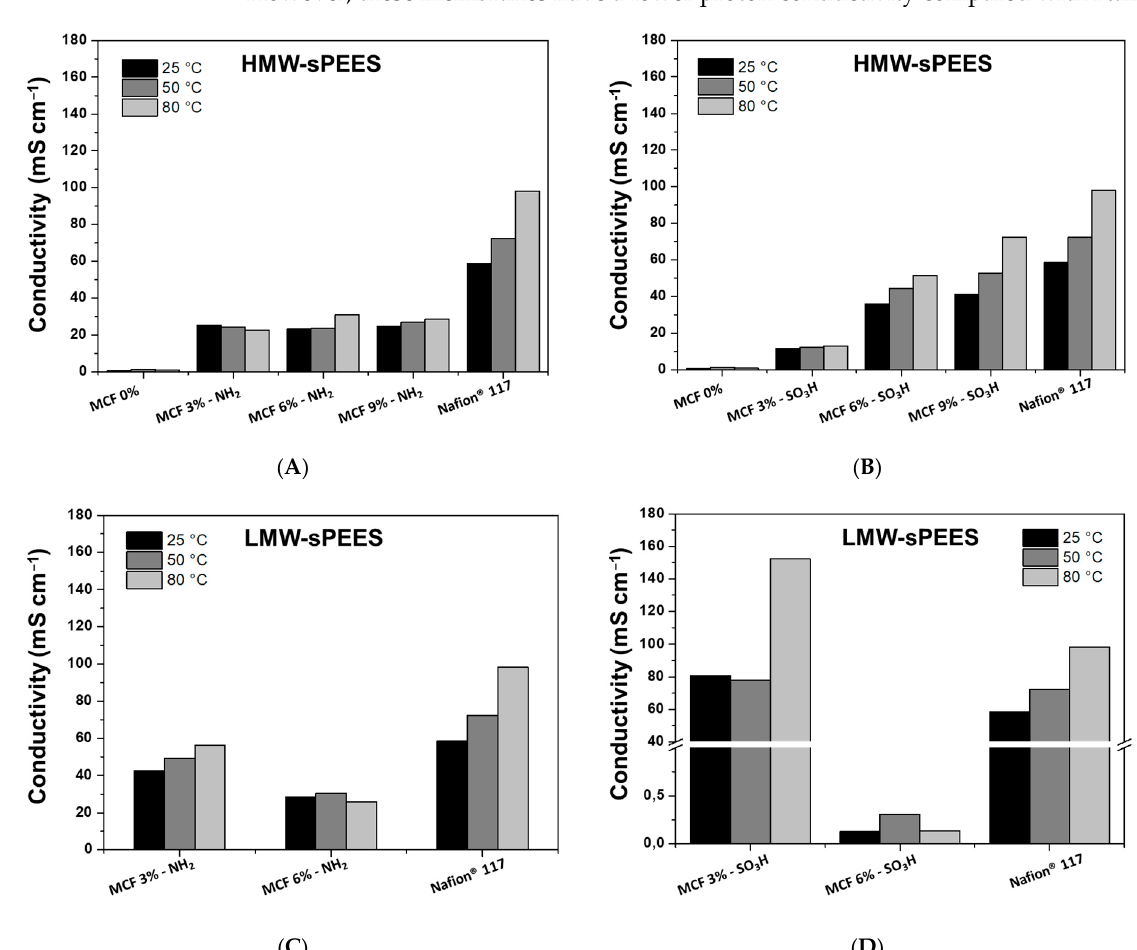
Figure 16. Proton conductivity measurements at different temperatures of membranes prepared from ( A ) HMW-sPEES MCF-NH 2 ; ( B ) HMW-sPEES MCF-SO 3 H; ( C ) LMW-sPEES MCF-NH 2 ; and ( D ) LMW-sPEES MCF-SO 3 H, and compared with Nafion ® 117.